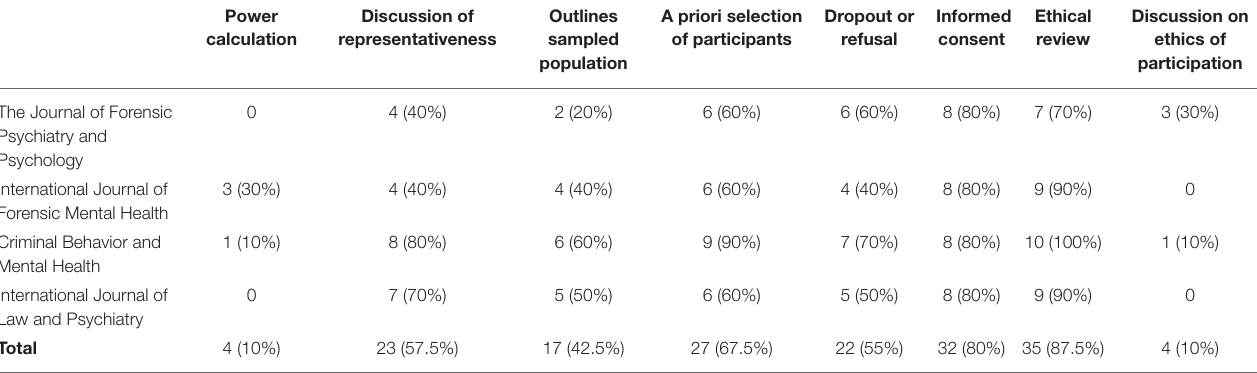
TABLE 1 | Numbers and percentages of the papers in our sample reporting power calculations, discussions of limits to representativeness in study, outline of sampled population, a priori selection of participants (inclusion and/or exclusion criteria at sufficient detail to assess the demarcation of the research population), dropout and/or refusal, explicit collection of informed consent, explicit mention of ethical review, discussions of ethics relating to recruitment or